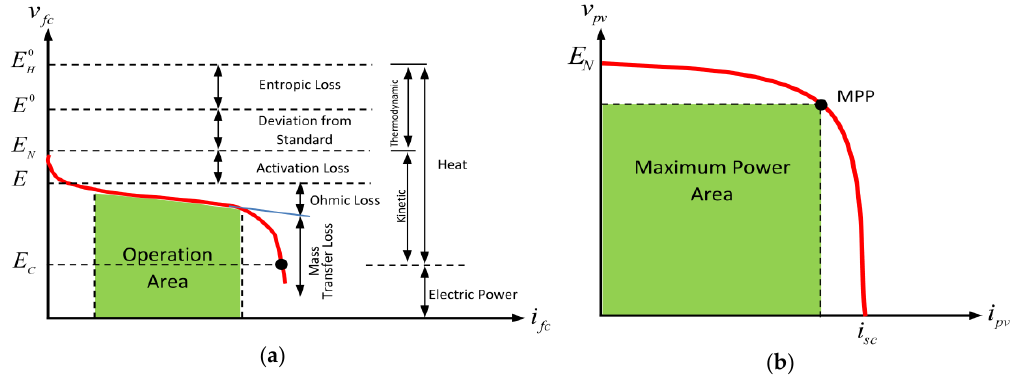
Figure 2. General electrical characteristic of micro sources ( a ) Characteristic of fuel cell; ( b ) Characteristic of photo voltaic panel.